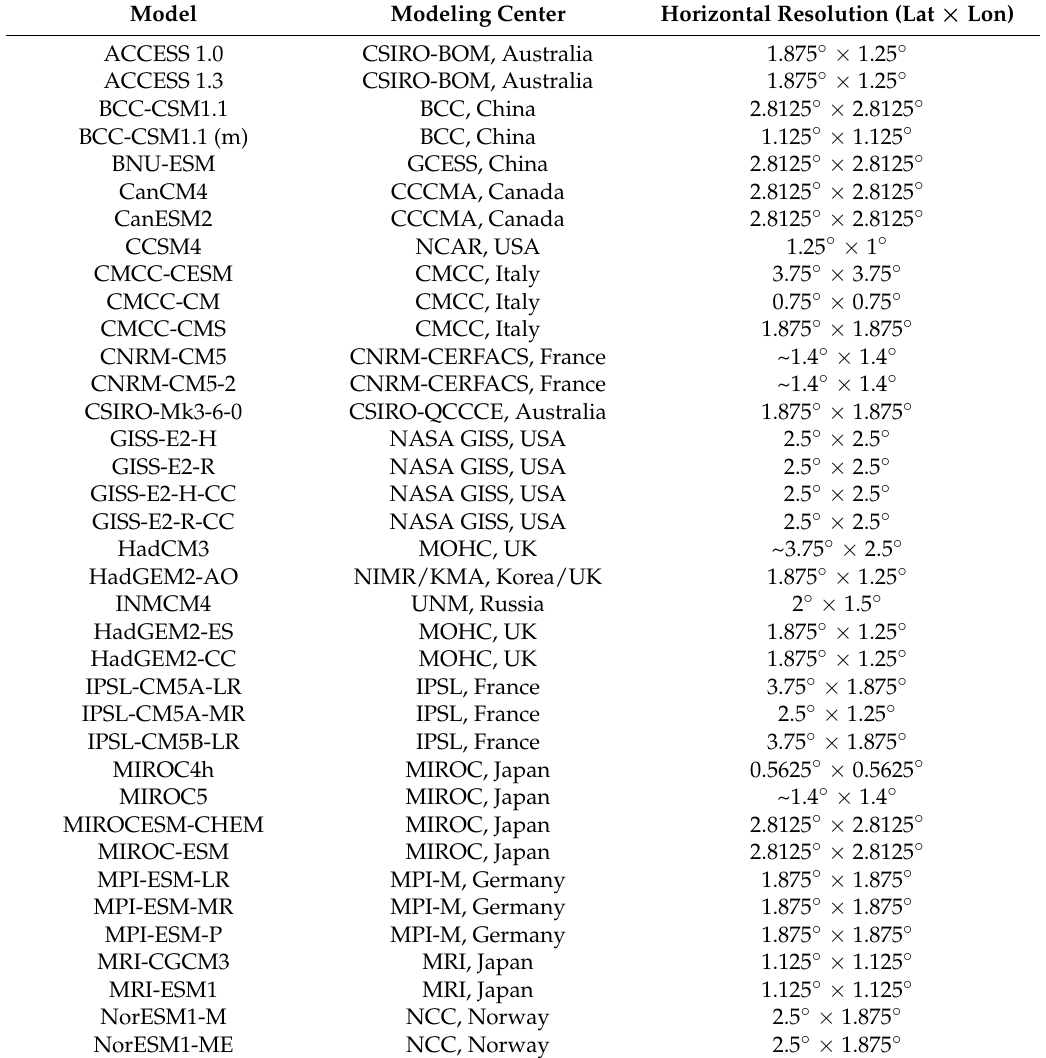
Table 1. Description of Coupled Model Intercomparison Project Phase 5 (CMIP5) global climate models (GCMs) used in our study and their spatial